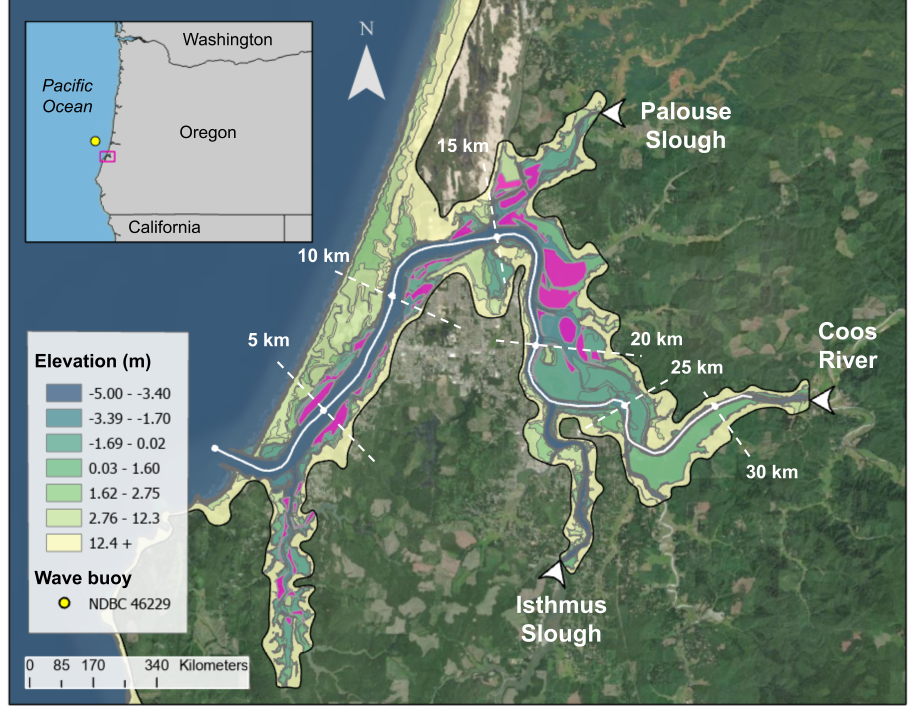
Figure 1. Site map of the CBE [65]. SAV habitats used to parameterize the ADCIRC+SWAN model shown in magenta. Riverine flow points shown with white arrows. White dashed lines correspond to along-channel distance landward of the CBE inlet ( dx